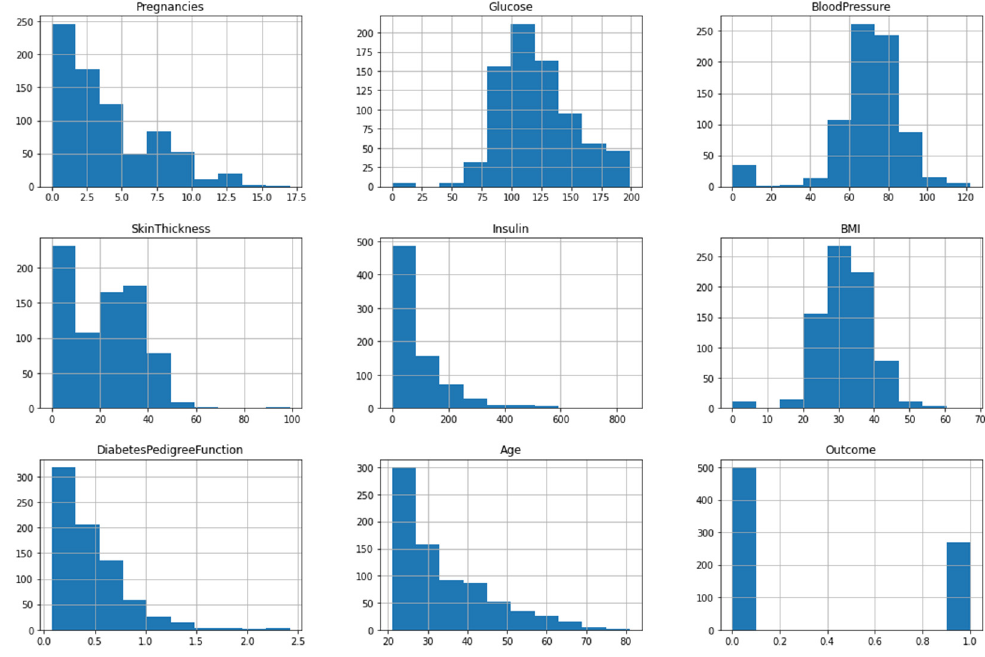
Figure 4. Data preprocessing.